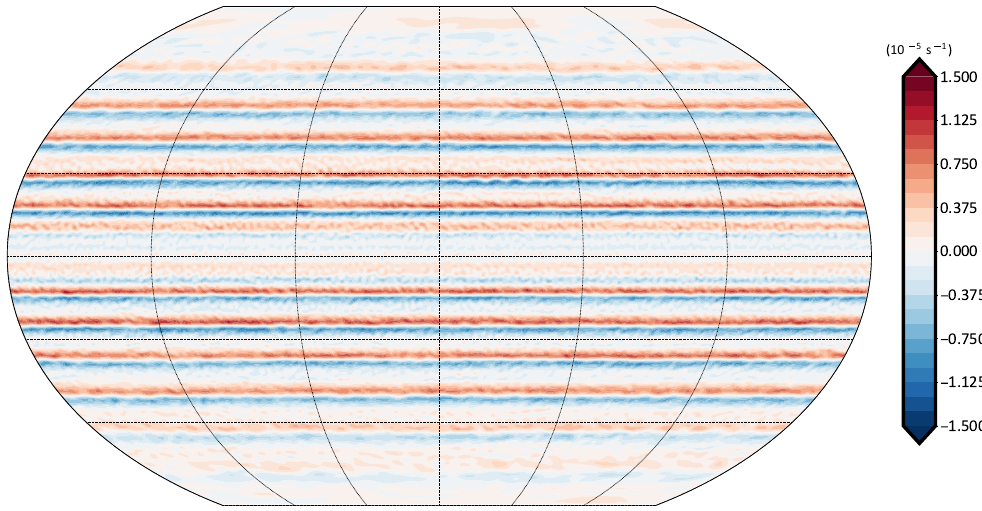
Figure 8. Time-averaged relative vorticity plotted on the 500hPa surface, taken from a giant planet simulation with Isca, as described in the text. Multiple zonally symmetric zonal jets are visible. Time-averaging is over 720 Earth